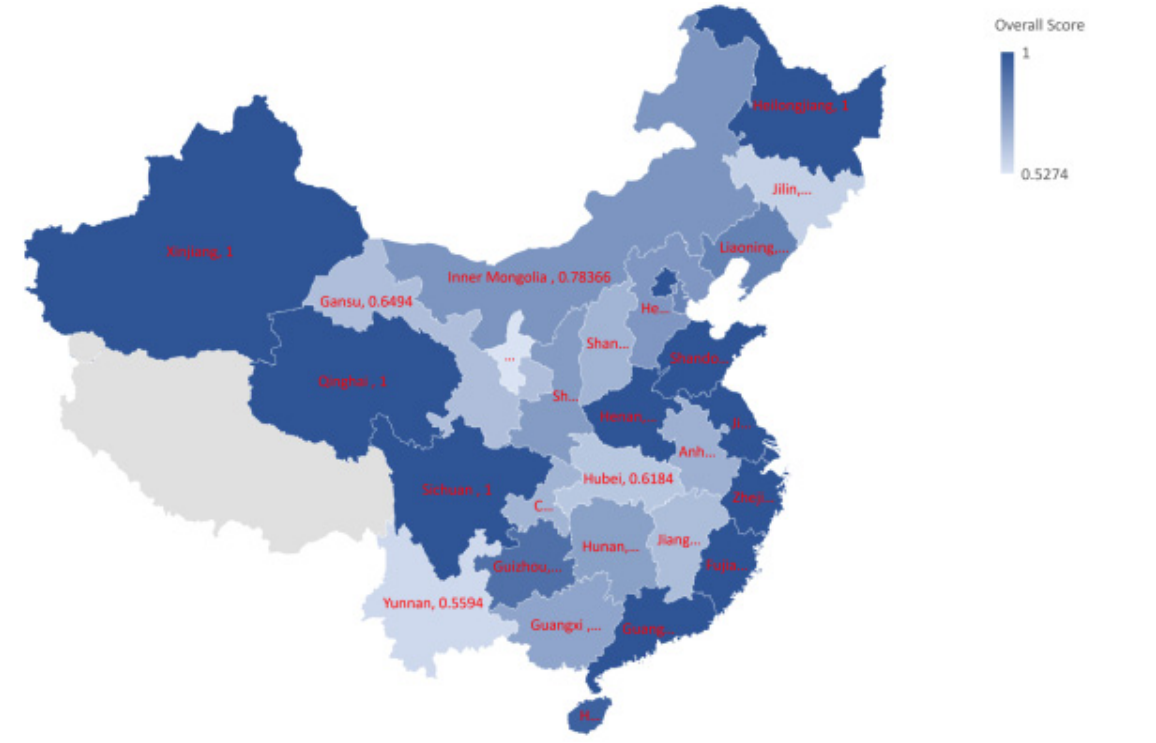
Figure 3. E ffi ciency without water. Figure 3. Efficiency without water. During the five-year period, the annual efficiencies of Tianjin were 0.527, 0.686, 1, 1, and 1, respectively, and the overall efficiency increased by 89.75%, indicating that Tianjin adopted effective resource allocation to improve efficiency. In addition, the annual efficien- cies of Jilin were 0.549, 1, 0.528, 0.452, and 0.405. Except for the best resource